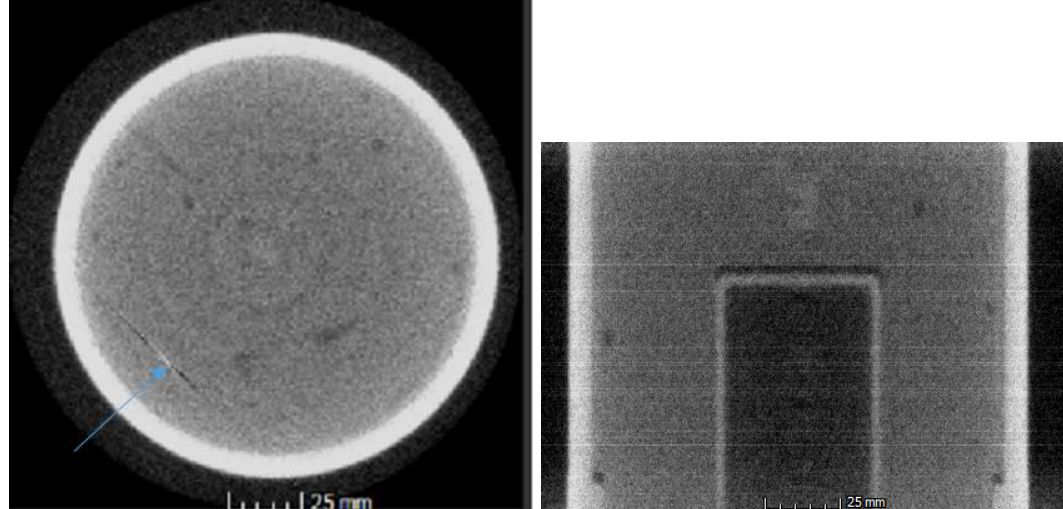
Figure 6. Left : A representative slice, exhibiting a hard hit from a neutron in the lower left (indicated by the blue arrow); Right : A side profile of the 3-dimensional reconstructed volume. Note the intensity streaks in the volume, which are partially due to hard hits and partially due to beam fluctuation. Visualizations created in Volume Graphics’ VGStudio Max (for information on VGStudio Max, see